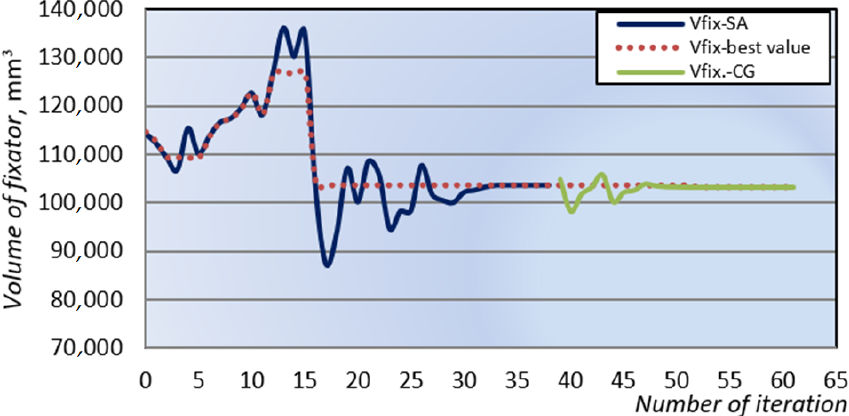
Figure 14. Optimization of volume of external fixation